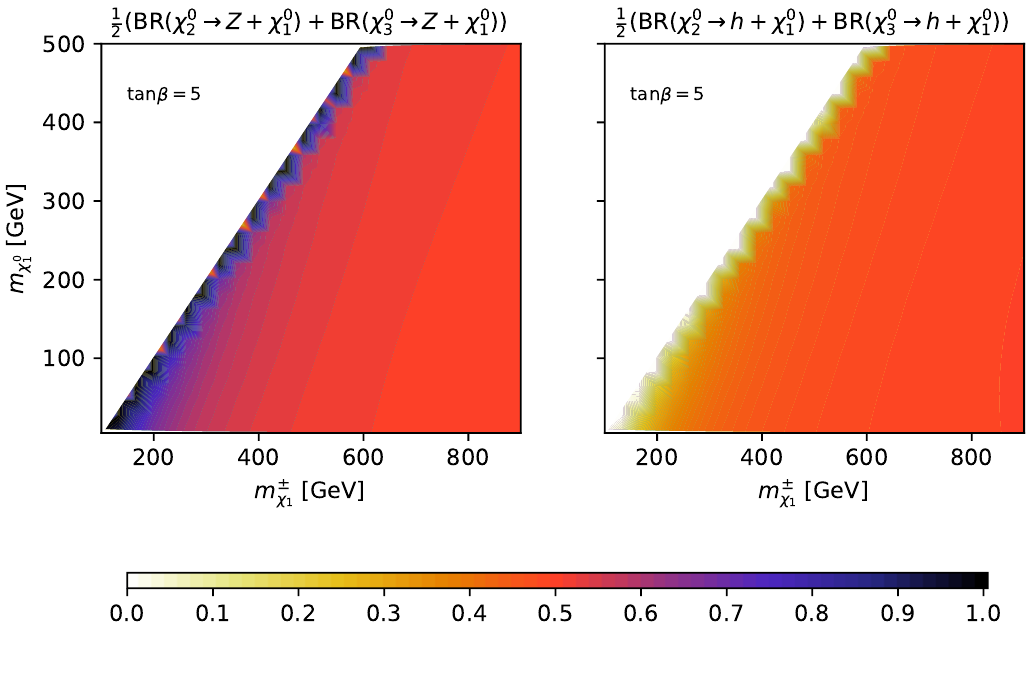
Figure 3 . Left: sum of the total branching ratio of Higgsinos to the Z boson, (cid:31) 0 normalized by 1 = 2. Right: sum of the total branching ratio of Higgsinos to the SM Higgs, (cid:31) 0 h + (cid:31) 0 , normalized by 1 = 2. We show contours resulting from the scan in eq. (2.5), for tan (cid:12) = 1